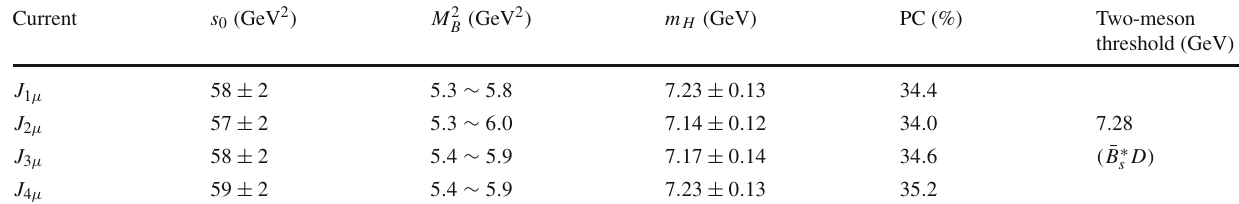
Table 2 The continuum threshold, Borel window, hadron mass and pole contribution for the bc ¯ q ¯ s system with J P = 1 +